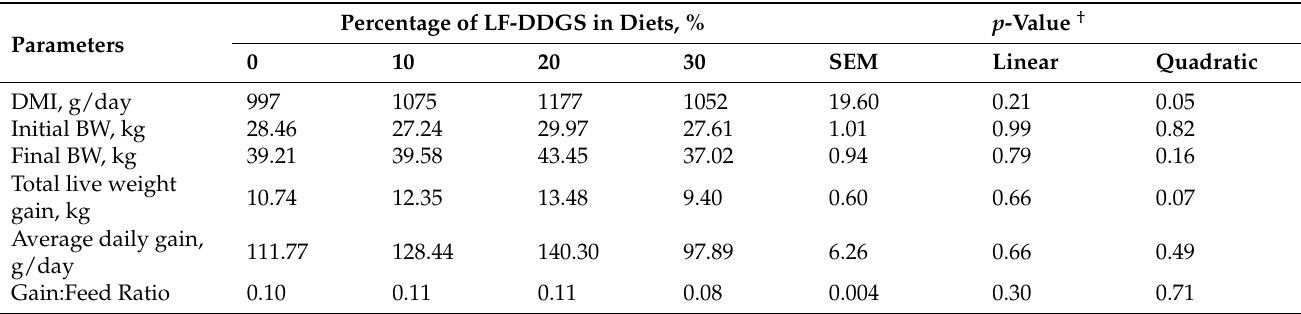
Table 3. Dry matter intake and growth performance of castrated male goats fed diets with different percentages of low-fat distillers dried grains with solubles (LF-DDGS) for 84 days.